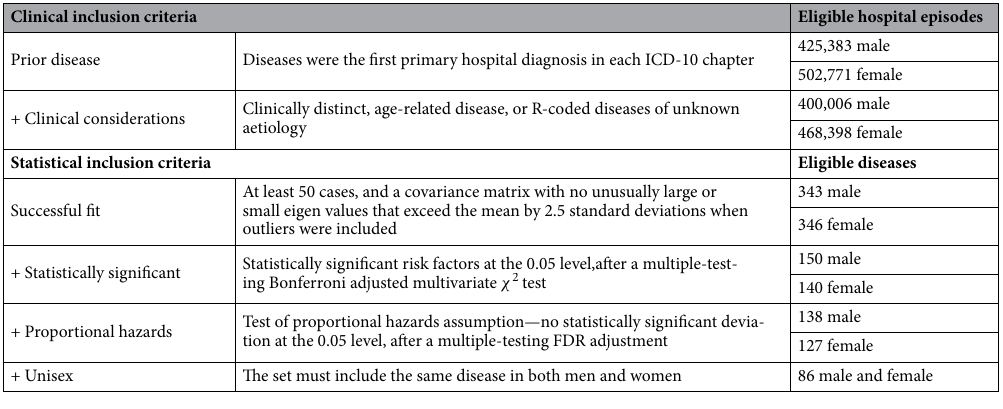
Table 1. Selection criteria for clustering of